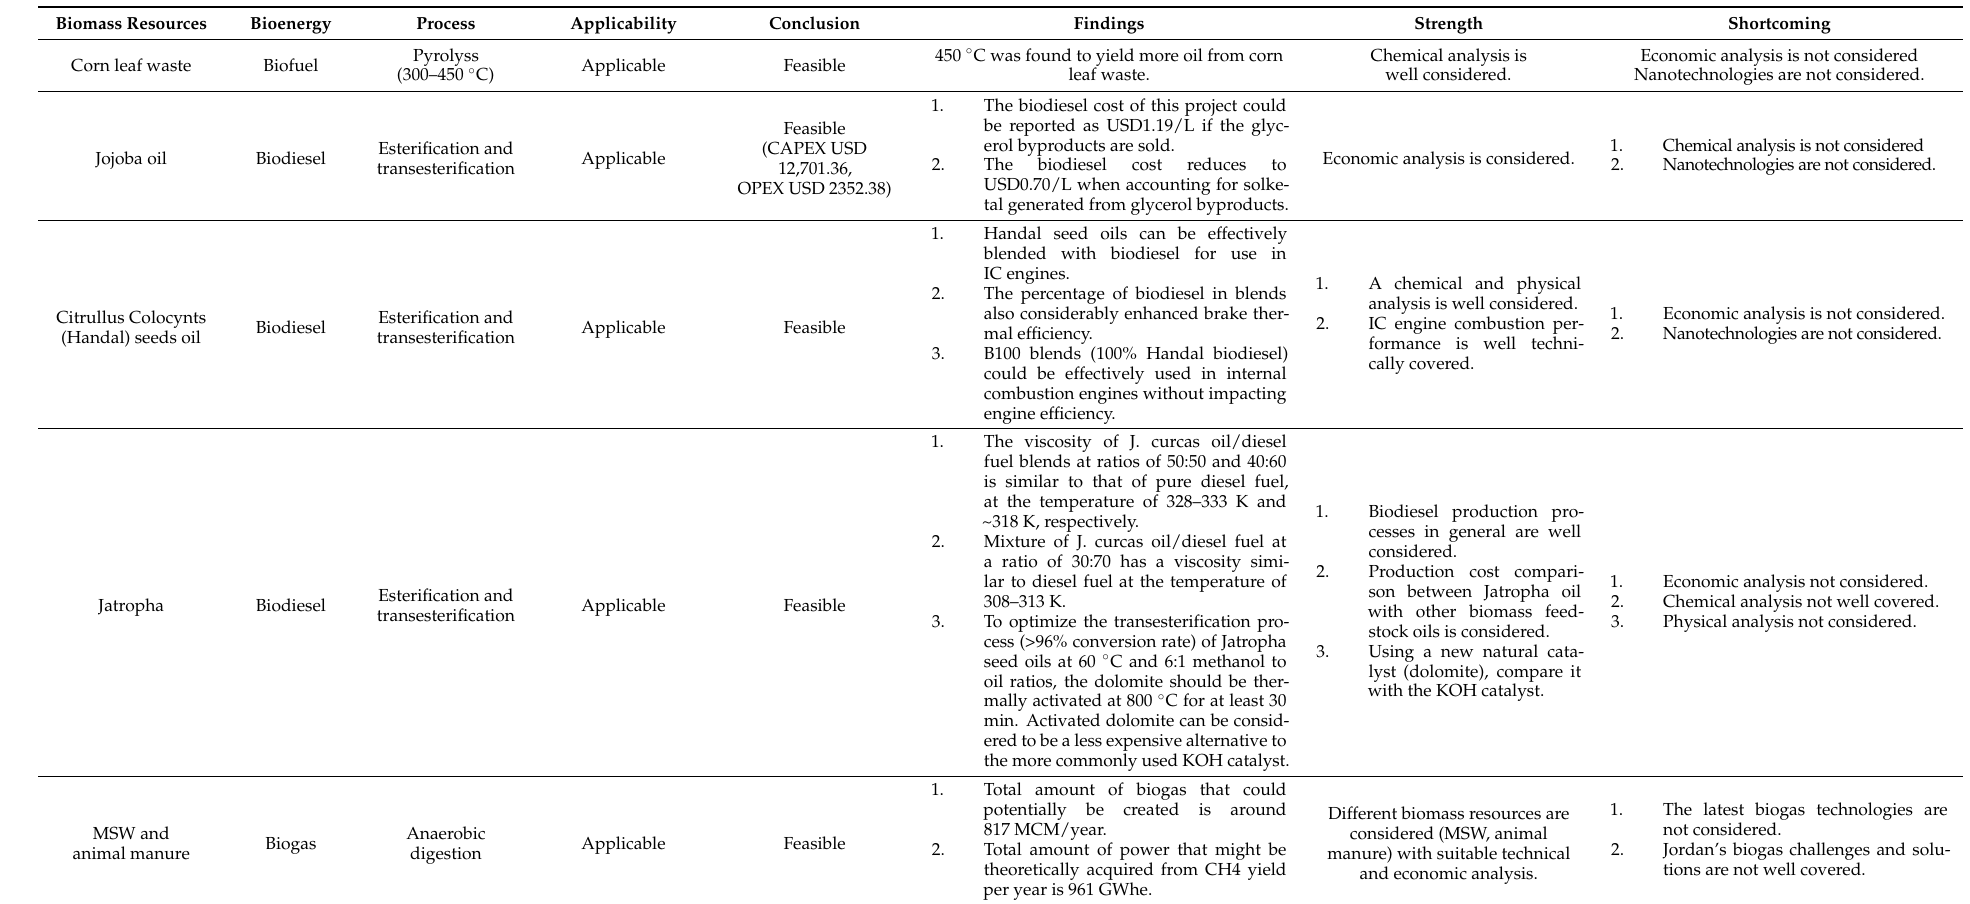
Table 13. Summary of Jordan’s